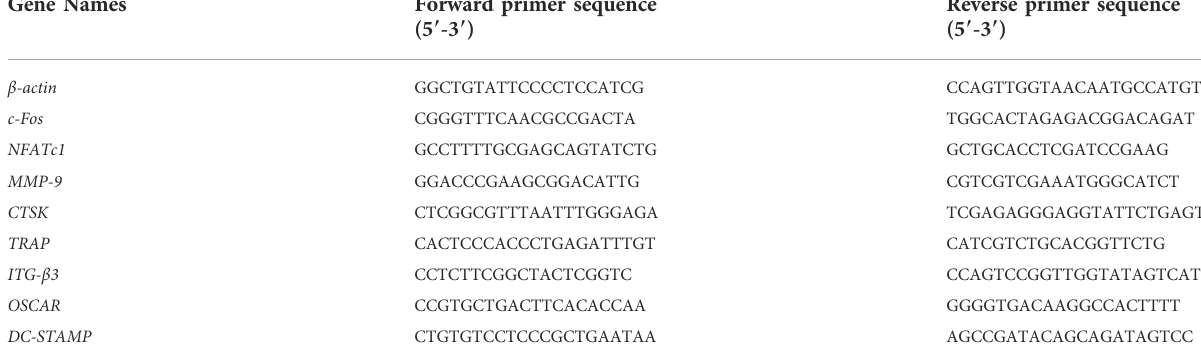
TABLE 1 RT-qPCR related